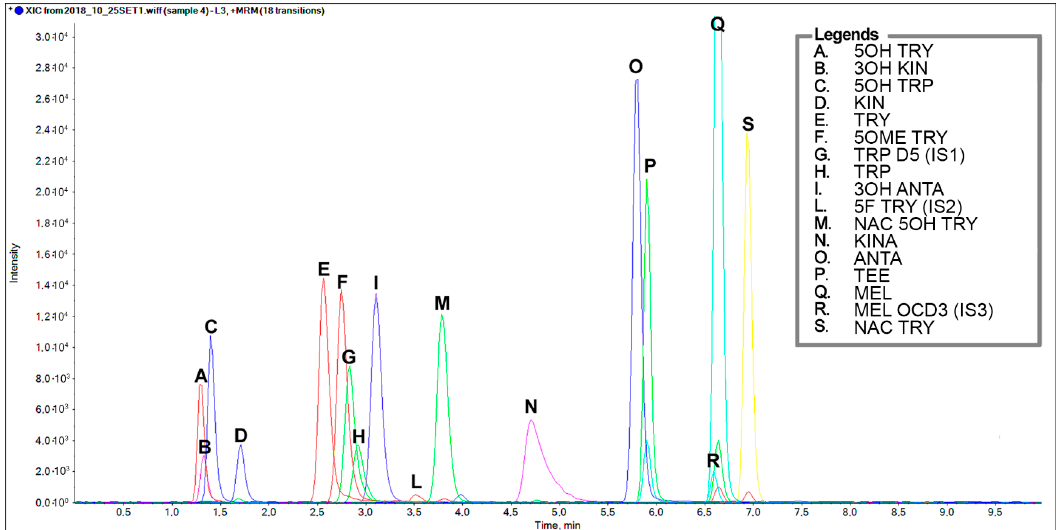
Figure 2. Representative chromatographic separation of a standard mixture of TRP-related metabolites containing an indole structure at a concentration 2 µg/mL, except for the internal standards: Tryptophan D 5 , 0.4 µg/mL; 5-F Tryptamine 20 ng/mL; Melatonin OCD 3 , 22 ng/mL. A. 5-OH Tryptamine, B.